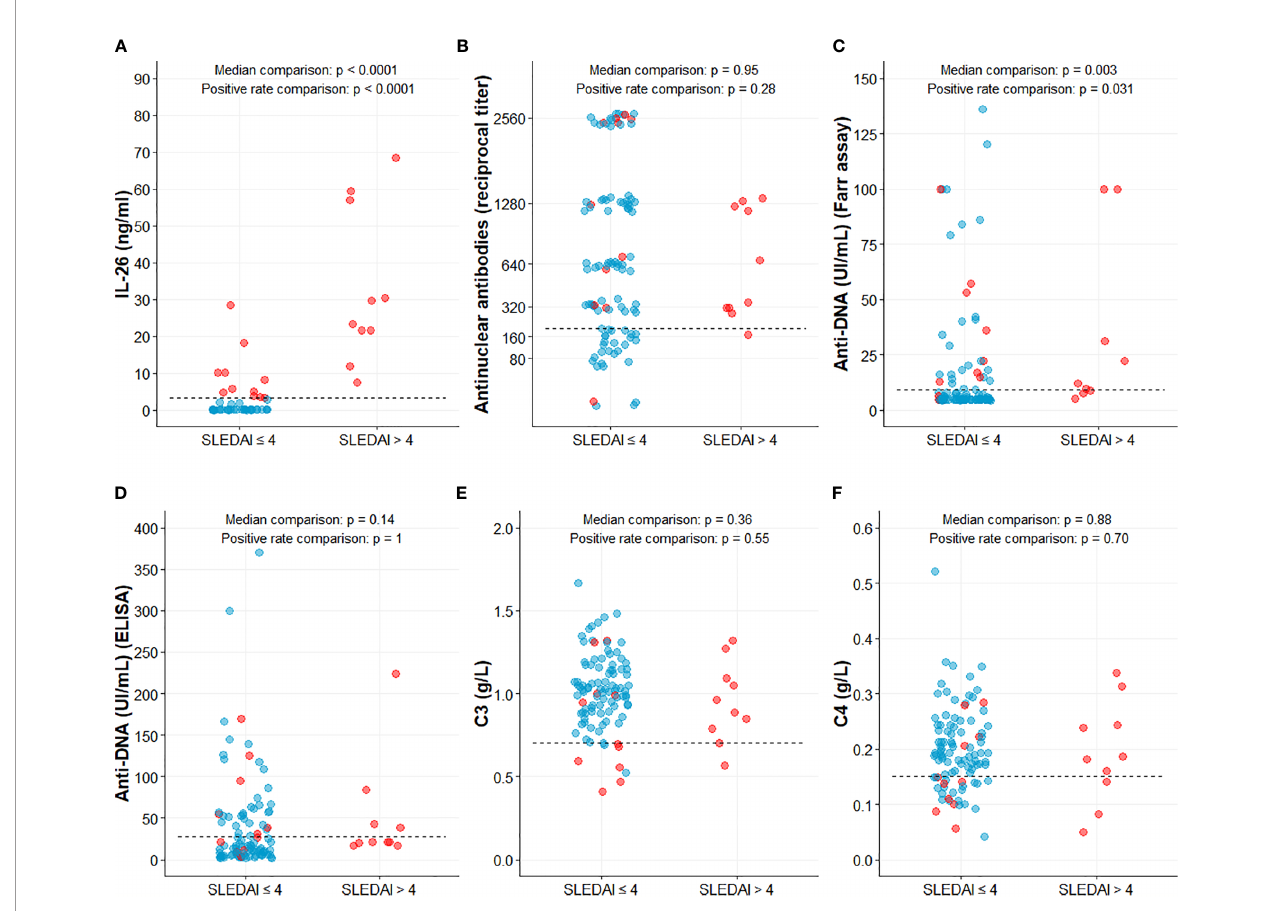
FIGURE 2 | IL-26 and classical markers according to SLE disease activity. IL-26 (A) , Antinuclear antibodies (B) , Anti-DNA antibodies (C, D) , C3 (D) and C4 (E) complement components levels. Data were compared with Mann-Whitney test (for median comparison) and with Fisher exact test [for percentage of positive patients (above threshold)]. Dashed line represents positivity threshold, set at 3.2 ng/ml for IL-26 (A) , 1/200 for antinuclear antibodies (B) , 9 and 28 UI/mL for anti-DNA antibodies (Farr assay and ELISA, C and D, respectively) or lower normal value (0.7 and 0.15 g/L) for C3 and C4 complement component respectively (E, F) . Blue and red dots represent patients in the low or high IL-26 groups respectively.